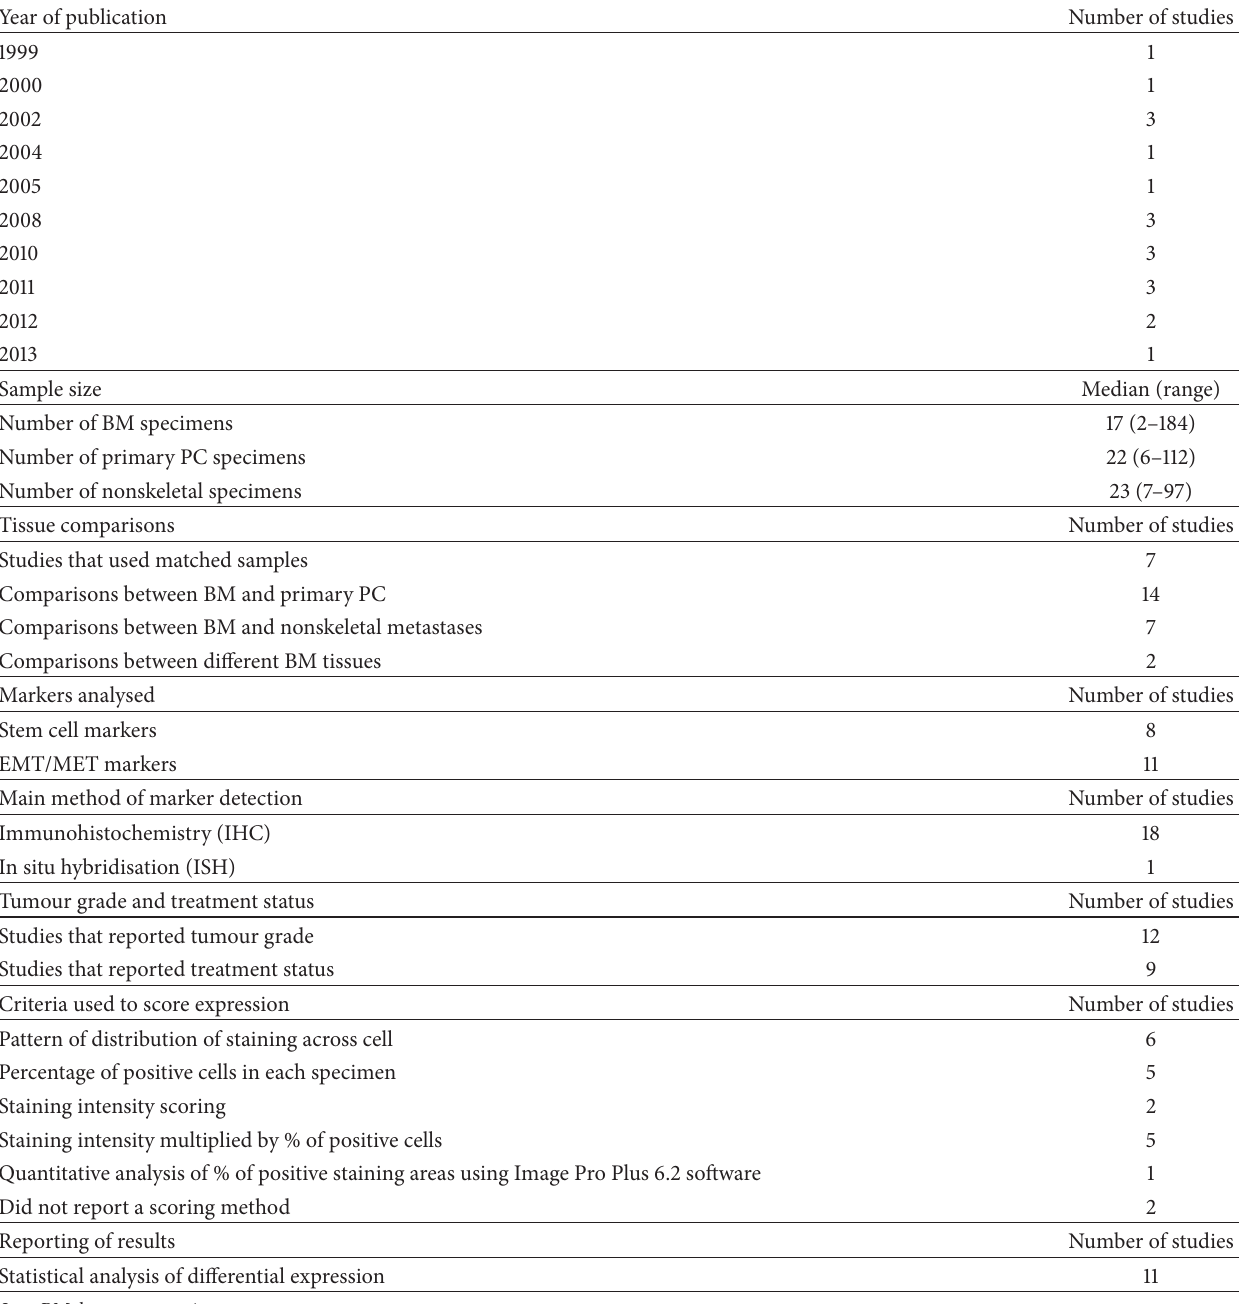
Table 1: Descriptive characteristics of included